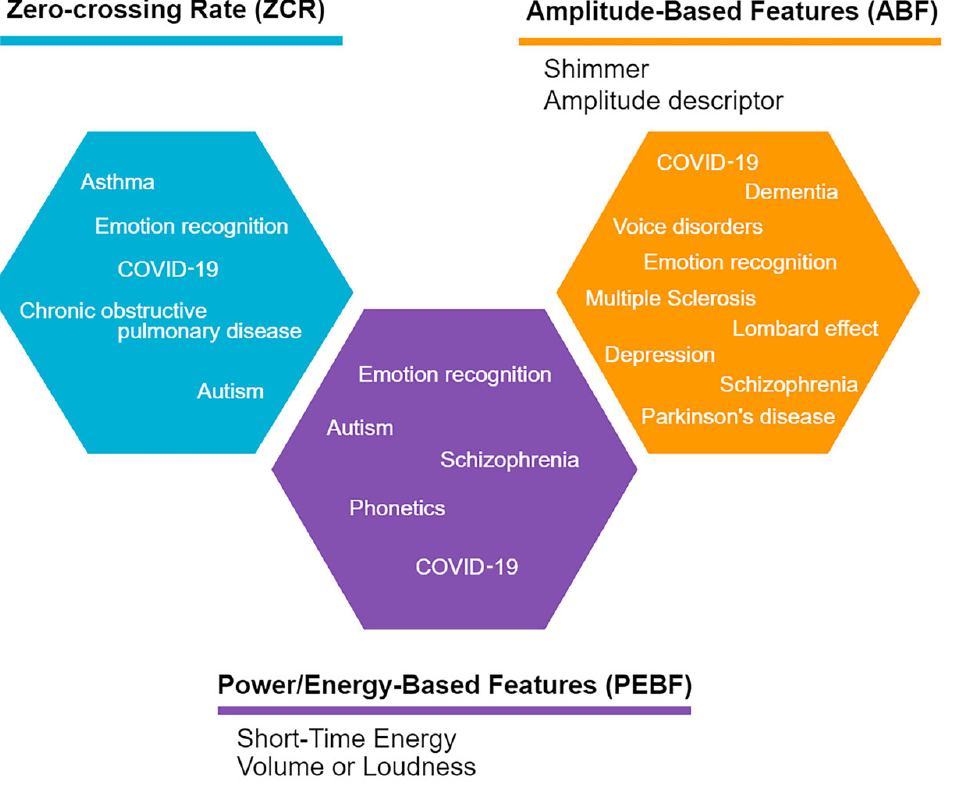
Figure 5. Most used acoustic features in the time domain from the revised literature. The main applications for each group of features are shown inside the hexagons.